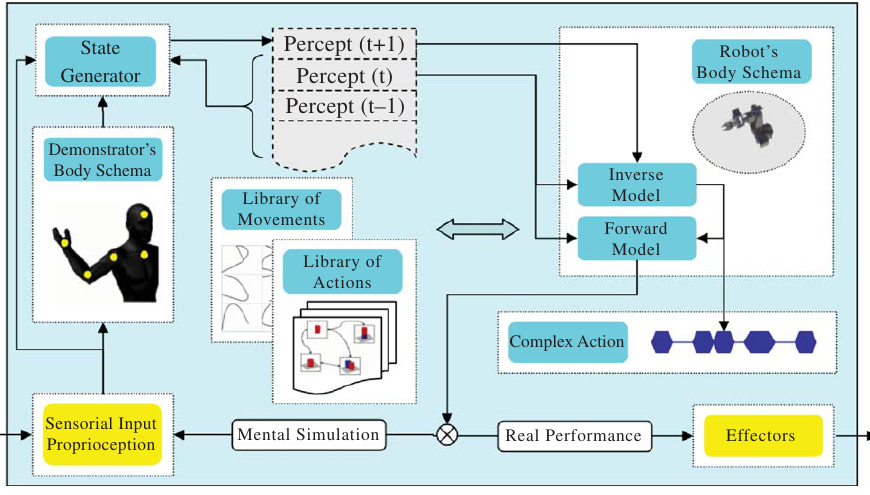
Fig. 2. The interaction of the body percept and the body schema, when the robot system is learning. The output from an action can be inhibited to the effectors, which will produce a mental rehearsal of the